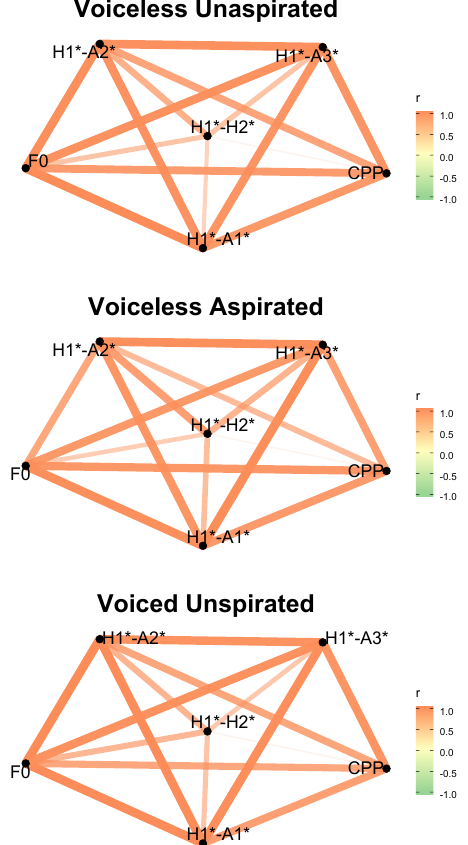
Figure 5. Correlation networks of F0, H1*-H2*, H1*-A1*, H1*-A2*, H1*-A3*, and CPP (collapsed across places of articulation). The thickness and colour shading of lines represent the strength of the relationships among all the acoustic variables. The absence of a line indicates very weak and/or no correlations among the